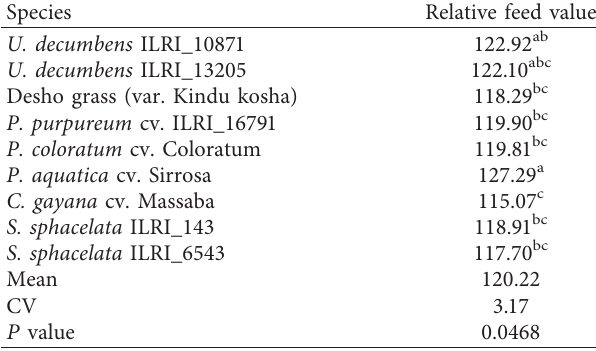
Table 8: Relative feed value (%) of perennial forage grass species evaluated under irrigation